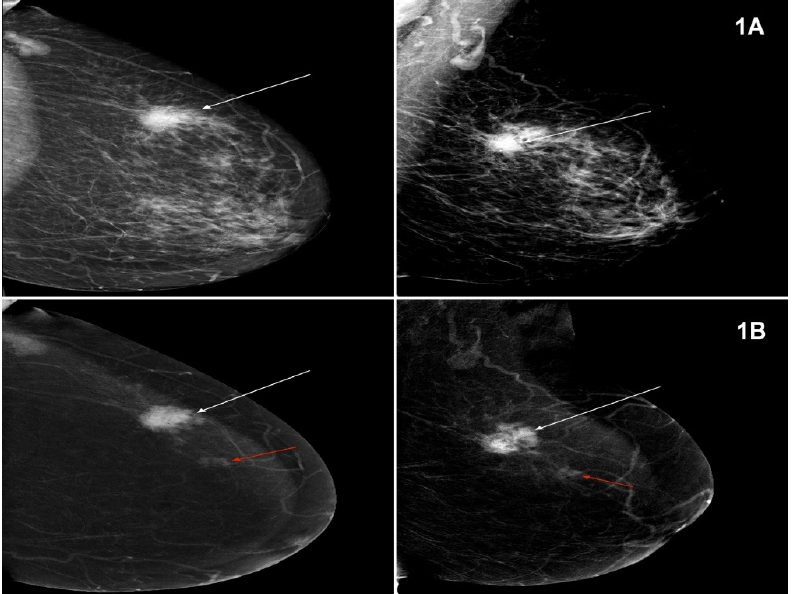
Figure 1. ( A ) Mammography (MG, low-energy images)—tumour in the left breast, in the upper external quadrant, measuring 35 mm—Breast Imaging Reporting and Data System (BI-RADS) 6 (white arrow). Projection: CC and MLO, HP-NST GIII. ( B ) Contrast-enhanced spectral mammography (CESM) (subtraction images)—tumour in the left breast, in the upper external quadrant, measuring 35 mm, enhanced upon contrast injection—BIRADS 6, HP: NST GIII (white arrow). A focus of amorphous contrast enhancement of a focal type, measuring 10 mm, at a distance of 25 mm from the tumour. BI-RADS 4 (red arrow). Projection: CC and MLO, HP-NST GII.